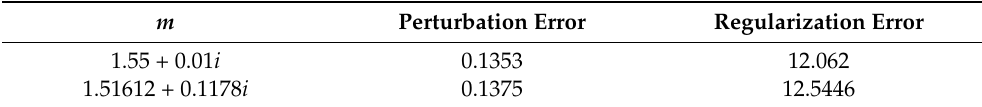
Figure 8. The PSDs when the selection of a complex refractive index is different in hazy weather using TSVD regularization inversion. Table 4. The corresponding errors when the selection of a complex refractive index is different in hazy weather using TSVD regularization inversion.